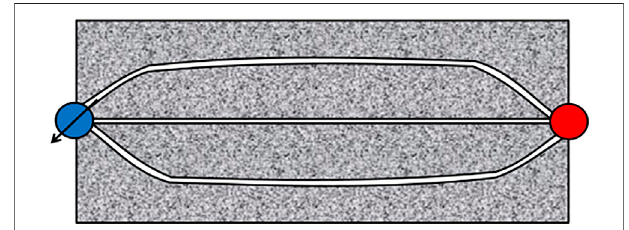
FIGURE 11 | Physical model of multifracture in parallel in one injection- production